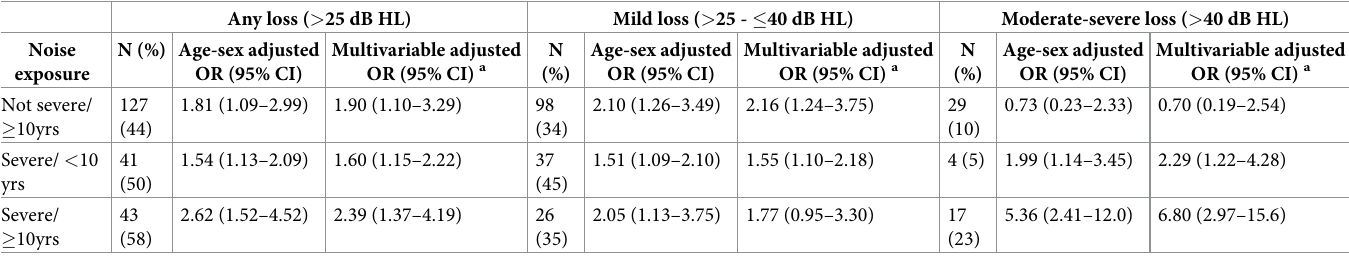
Table 2. Association between combined severity and duration of exposure to workplace noise and prevalent hearing loss, presented as Odds Ratio (OR) and 95% Confidence Interval (CI). Any loss ( > 25 dB HL) Mild loss ( > 25 - � 40 dB HL) Moderate-severe loss ( > 40 dB